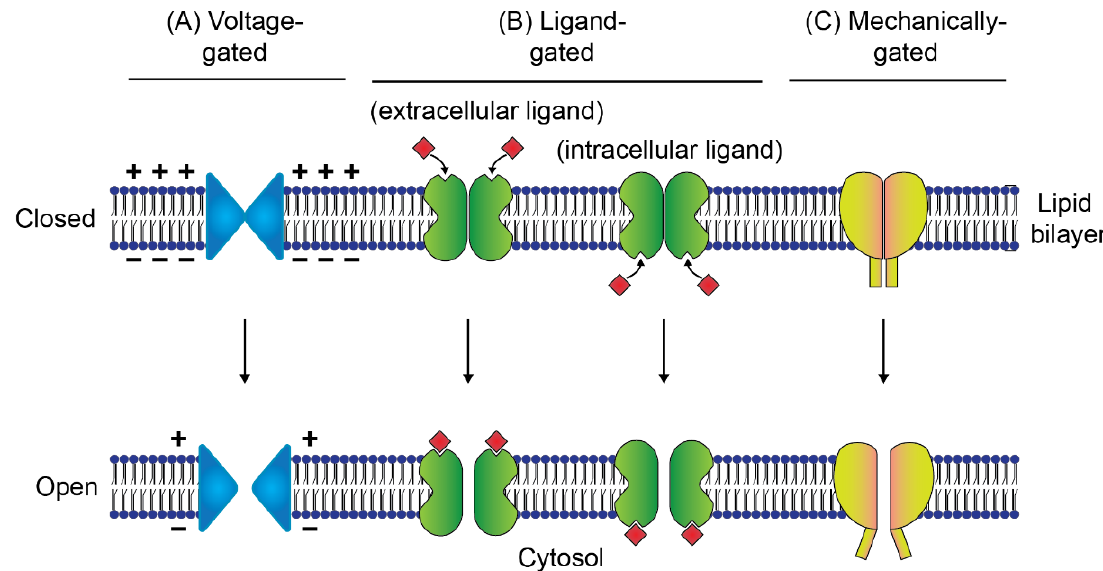
Figure 2. Types of gated ion channels. ( A ) Voltage-gated channels are ion-selective and open upon perturbation of the potential of cell membrane, ( B ) ligand-gated channels are sensitive to specific ligands and they are classified as extracellular and intracellular ligand-gated channels based on the position of ligands in the channel, and ( C ) mechanically gated channels sense forces and transduce the forces into electrical and/or chemical intracellular signals through the cell membrane and cytoskeleton.